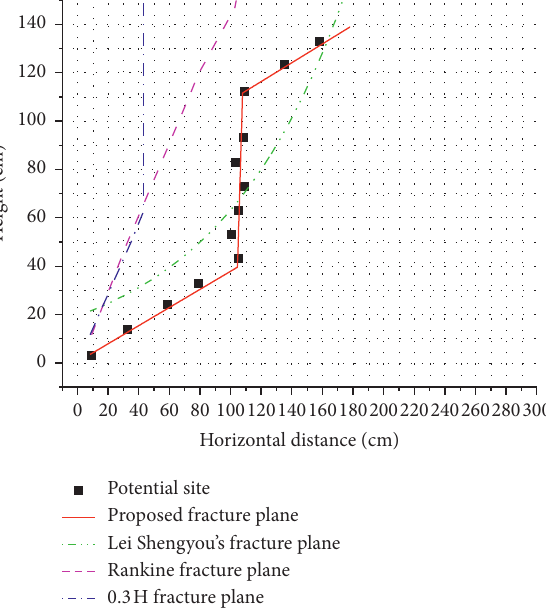
Figure 10: Potential fracture surface obtained by different cal- culation